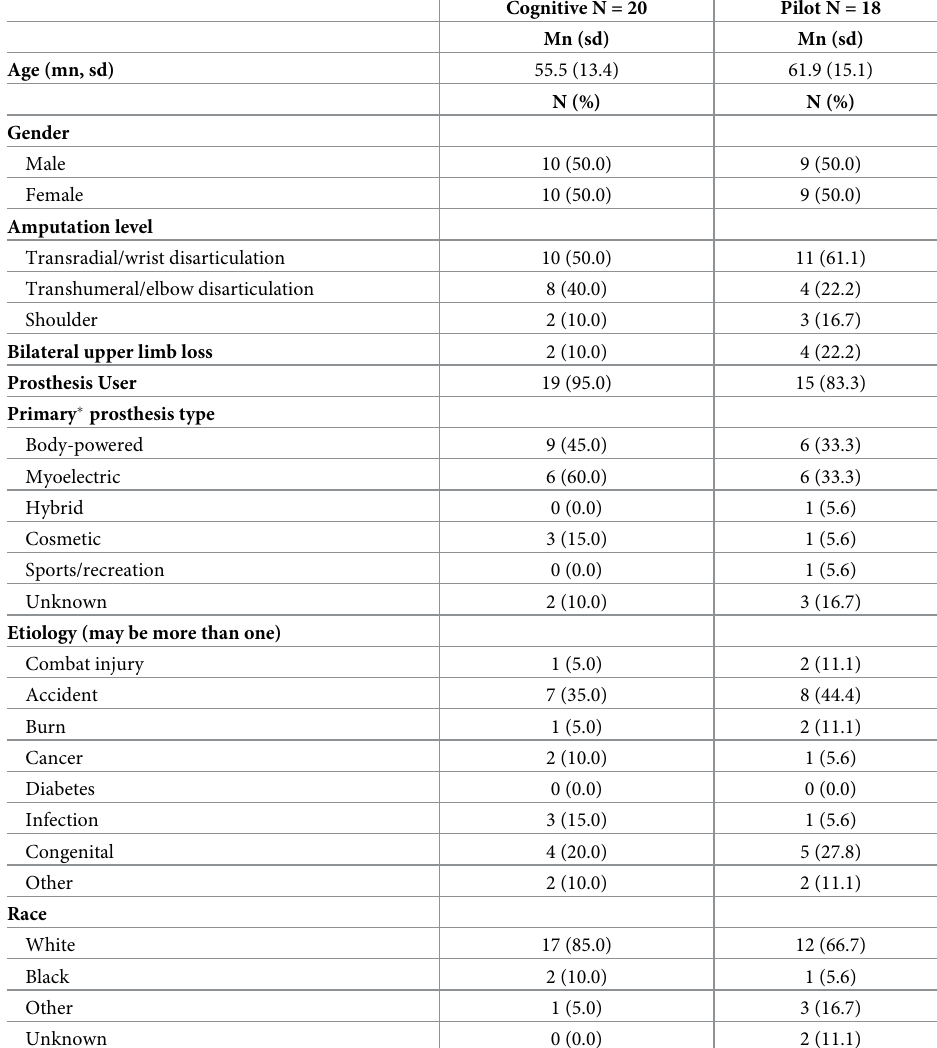
Table 1. Participants in the cognitive testing and pilot